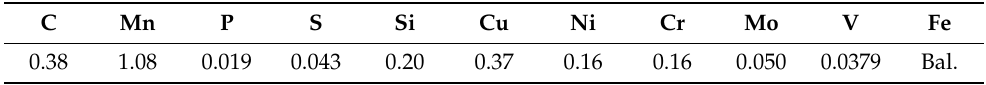
Table 1. The composition of carbon steel